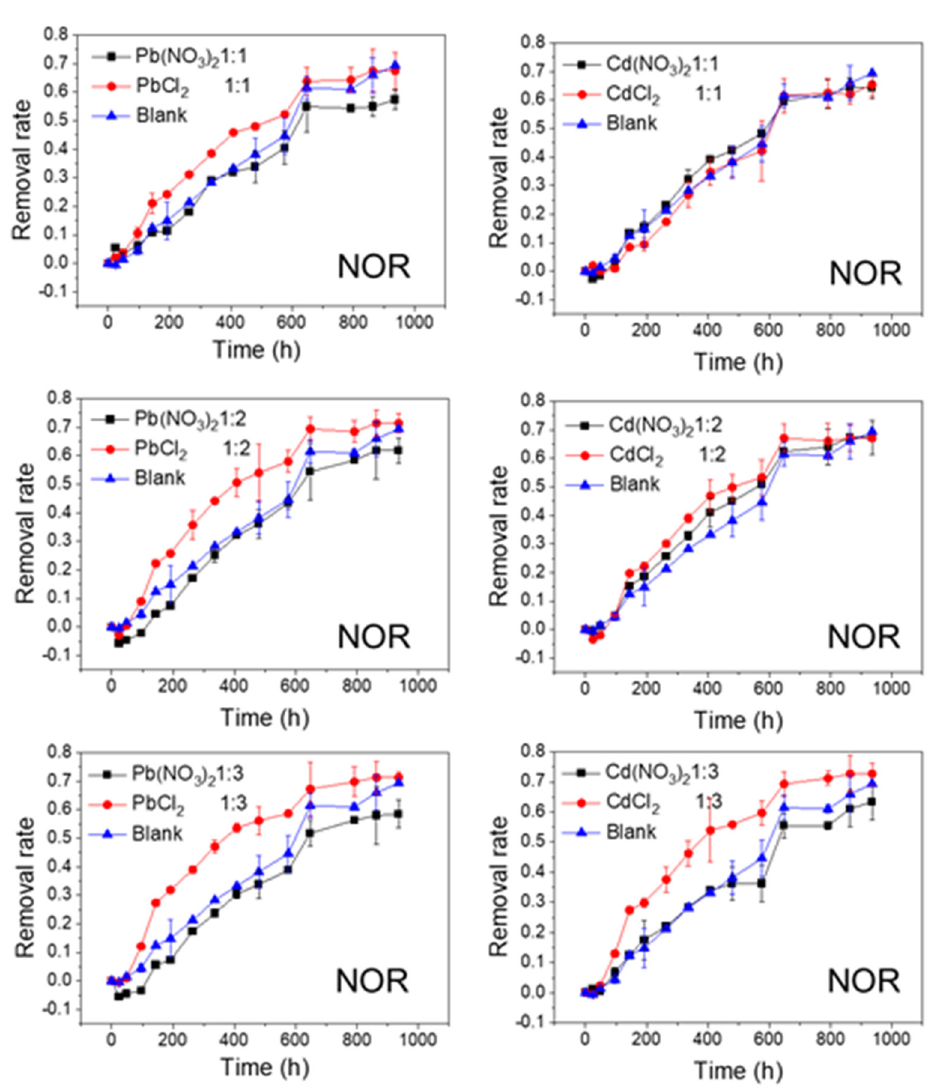
Figure 4. Photolytic degradation of NOR (0.012 mmol/L) with the effects of NO 3 − and Cl − at different molar ratios; Blank means no heavy metal ions added.